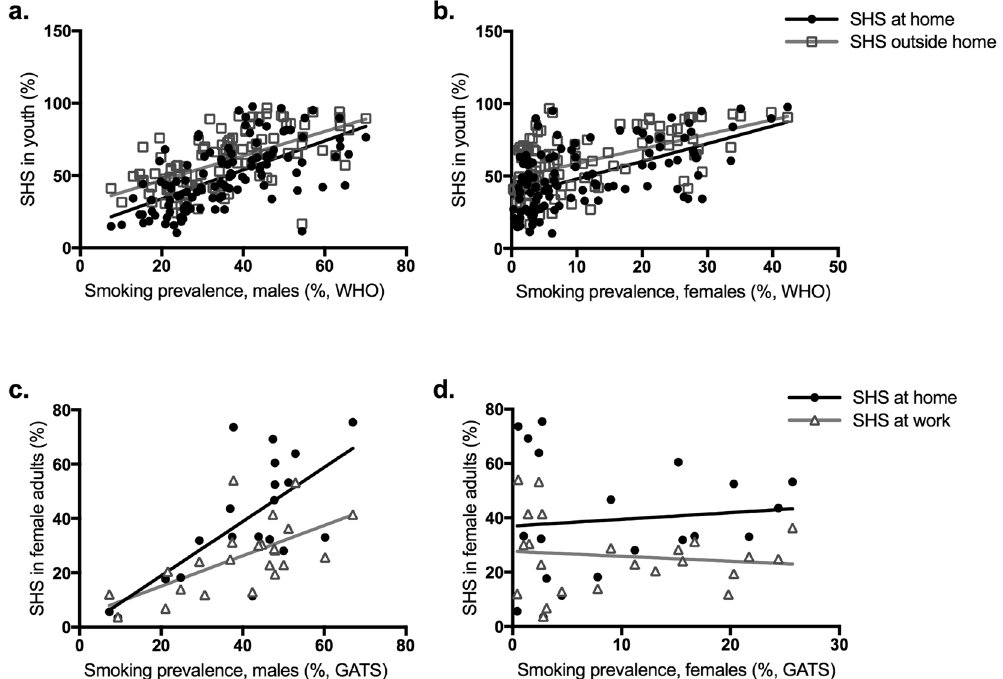
Figure 5. Correlation analyses of population smoking metrics and reports of secondhand smoke exposure. ( a ) Male and ( b ) female smoking prevalence percentages compared to secondhand smoke exposure reported by youths 13–15 years old for exposures at home and outside the home, all extracted from WHO’s 2008 report on the global tobacco epidemic. ( c ) Male and ( d ) female smoking prevalence percentages compared to secondhand smoke exposure reported by female adults for exposures at home and at work, according to the Global Adult Tobacco Survey accessed through CDC databases. SHS = secondhand